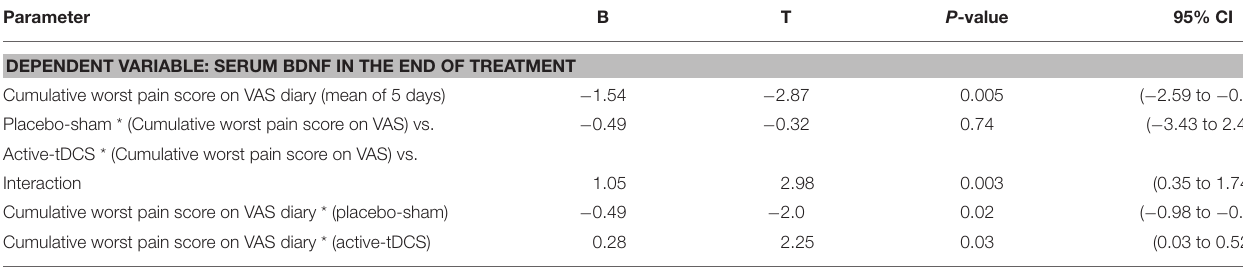
TABLE 2 | Multivariate linear regression of the pain reported compared with BDNF, treatment group and daily pain VAS ( n = 24 ). Parameter B T P -value 95% CI DEPENDENT VARIABLE: SERUM BDNF IN THE END OF TREATMENT Cumulative worst pain score on VAS diary (mean of 5 days) Placebo-sham * (Cumulative worst pain score on VAS) vs. Active-tDCS * (Cumulative worst pain score on VAS)